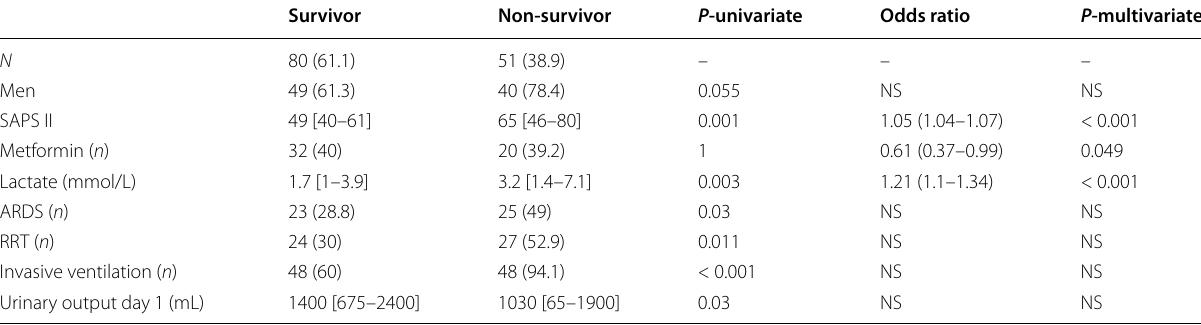
α 0.05. Area under the curve of the multivariate model = RRT renal replacement therapy, NS not